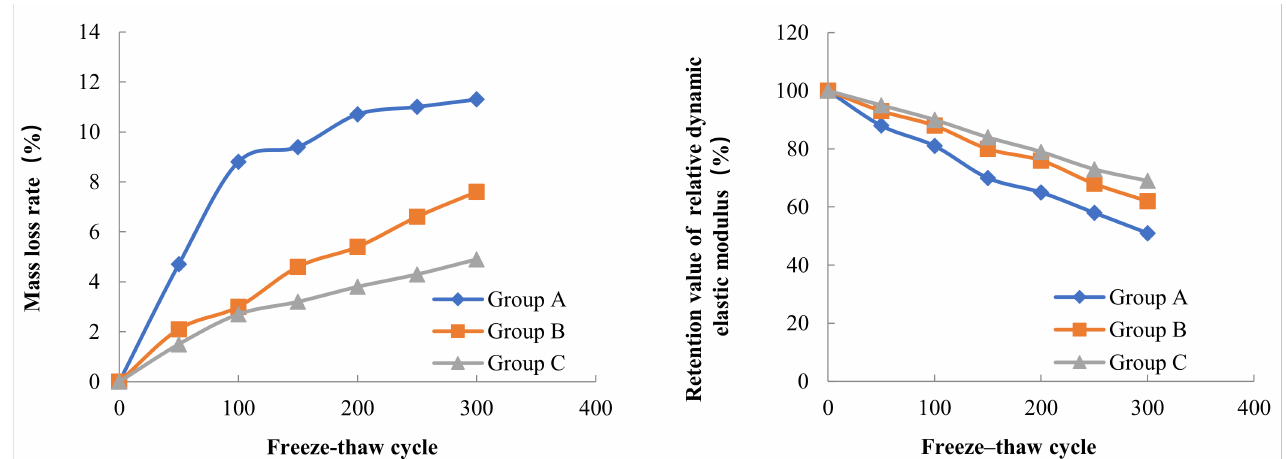
Figure 2. Frost resistance of concrete with different internal humidity ( − 17 ◦ C freezing temperature).